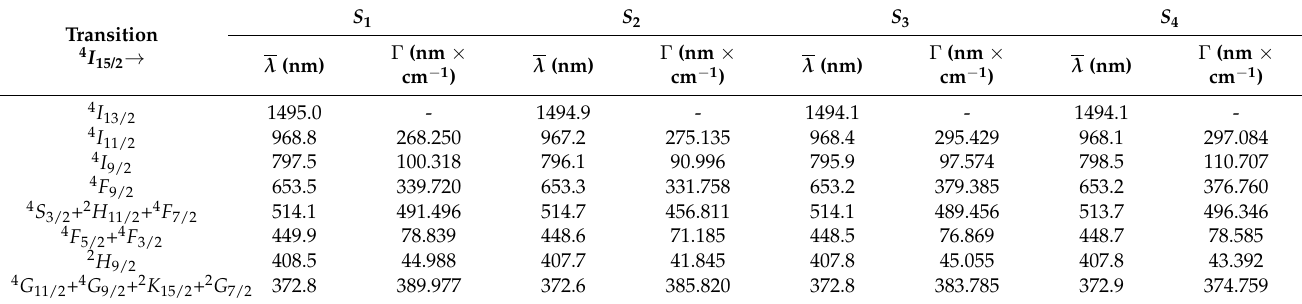
Table 1. The mean wavelengths ( λ ) and integrated absorption coefficient ( Г ) corresponding to electron transitions of Er 3+ :YAG (Er 3+ :YSAG) ceramic samples at 300 K.